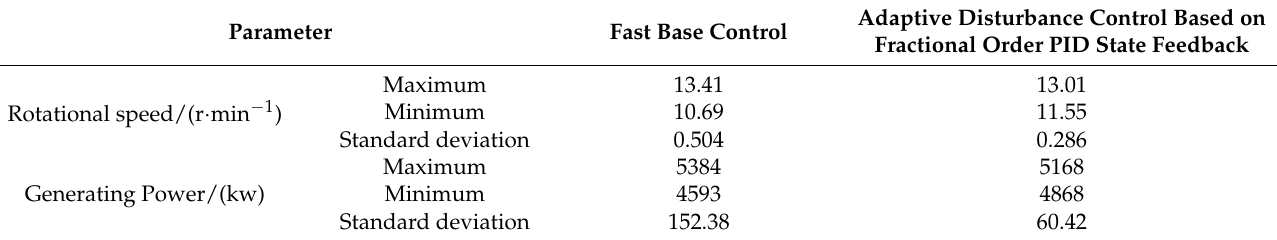
Table 3. Control effect parameters under different controllers.